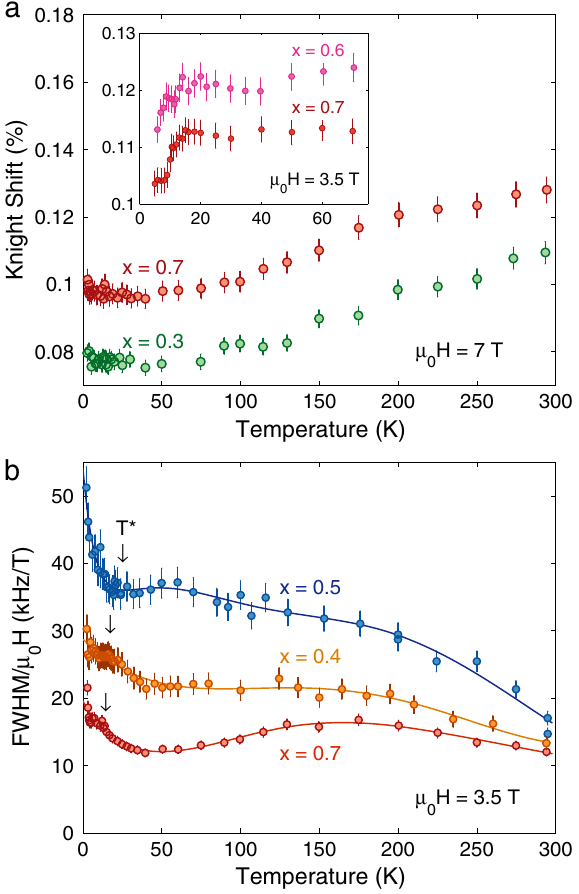
Fig. 4 Weakly increasing linewidths re fl ect lack of magnetic order. Representative 31 P NMR shifts ( a ) and line widths ( b ) vs. temperature, measured at 3.5 and 7 T. The full lines are guides to the eye. A drop in shift below T c (arrow) is observed only at 3.5 T (inset). The line widths show only a moderate increase below T * for all x values and applied fi elds Fig. 5, the recovery occurs over many decades, re fl ecting a wide distribution of relaxation rates. The evolution of β with temperature indicates a smooth decrease from 1, the canonical value for simple disorder-free metals, to almost 0.5 close to T = 0 K. Such a strong reduction of β is typical of samples with disorder, where the inequivalence of NMR sites increases as the temperature is lowered. 37 As shown in Fig. 5, samples having the same degree of disorder exhibit a very similar β ( T ) dependence. Yet, the vertical offset, most likely indicates again a different degree of electronic correlations above and below x = 0.5. Figure 6a summarizes the extensive 1/( T 1 T ) dataset, collected at both fi elds and for all the samples. Unlike the Knight-shift and linewidth data, the 1/( T 1 T ) vs. T curves are practically independent of the applied fi eld for all the investigated x values. We recall that Þ = f fl uctuating hyper fi ne r probes the fi elds at a nuclear site and, as such, it represents a measure of the dynamic correlations. Here, F is the tensor of the hyper fi ne form- factor, while χ ″ represents the imaginary part of the dynamical electronic susceptibility. The main feature of the reported ( T 1 T ) − 1 ( T ) data is the presence of low-temperature peaks of varying magnitude. The substantial increase of ( T 1 T ) − 1 upon lowering the temperature indicates an increase in the dynamical susceptibility, typical of a magnetic instability and/or spin